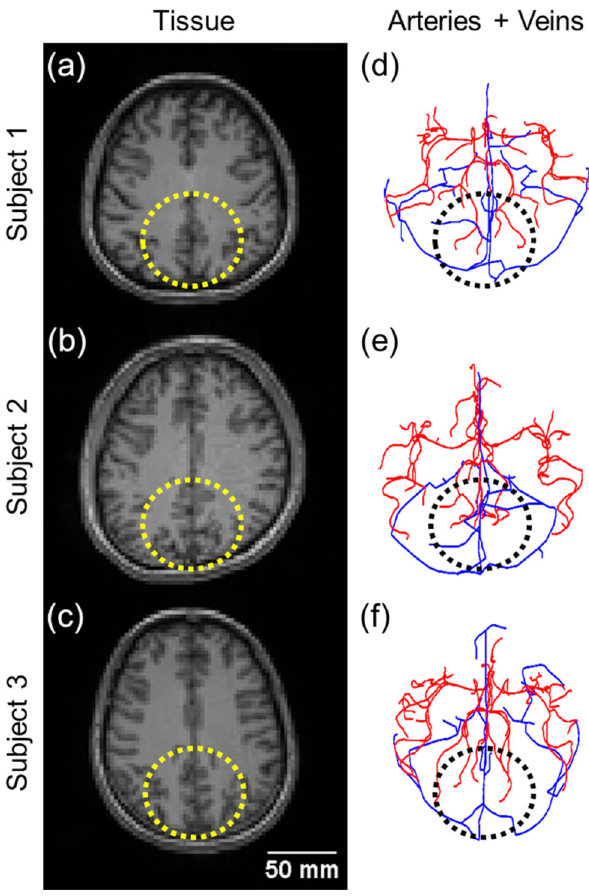
Fig. 2 Subject-speci fi c tissue and vessel structure. a – c Tissue structure for each subject was acquired from T1-weighted magnetic resonance (MR) images. Yellow ovals highlight unique gray and white matter distribution patterns for each subject. d – f Arterial (red) and venous (blue) structures were generated from segmented MR angiography and venography data, respectively. Black ovals highlight the unique arterial and venous morphology in the posterior region of each subject. Scale bar is 50 mm and all images are on the same scale. The arteriovenous structure is on the same scale as the corresponding T1-weighted MR